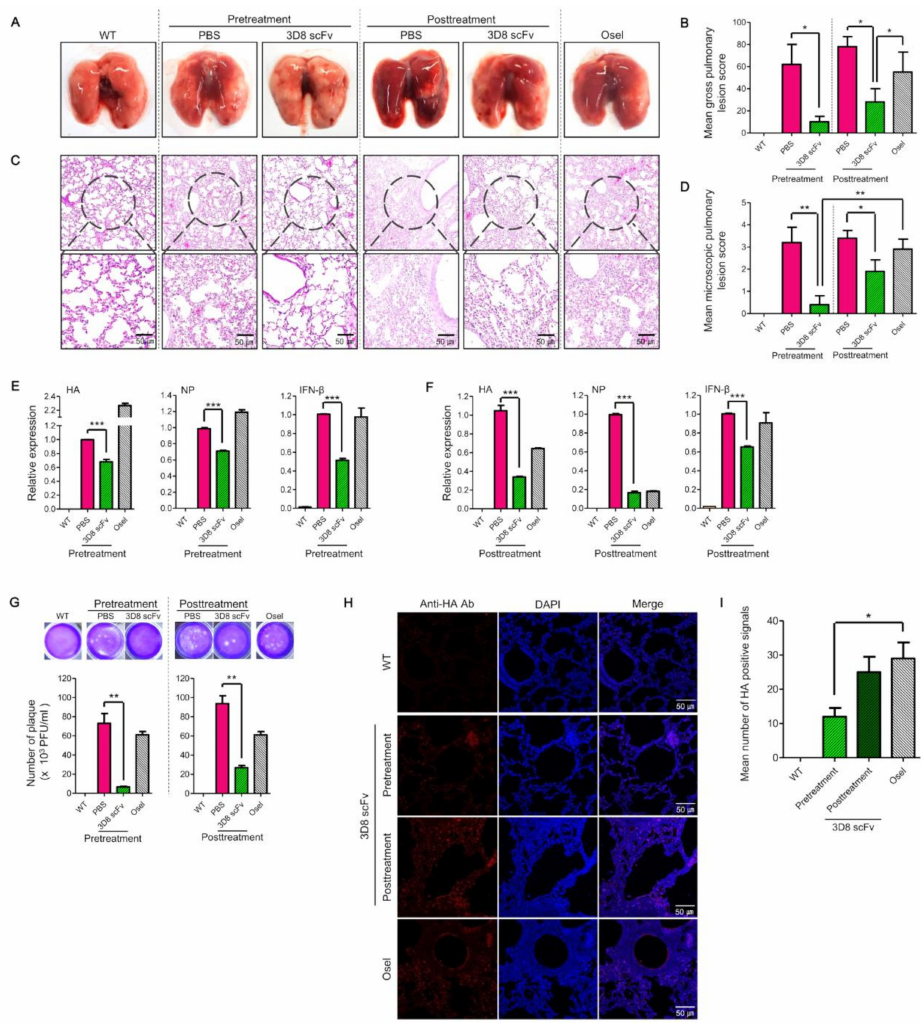
Figure 4. Histopathological analysis of the lung tissues of H1N1/H275Y-infected mice after intranasal 3D8 scFv treatment. ( A , B ) A morphological comparison and the gross pulmonary lesion scores of the mice’s lungs. The mice’s lungs were harvested at 5 dpi. ( C , D ) A histopathological comparison and the microscopic pulmonary lesion scores of the mice’s lung sections. Images of lung sections from virus-infected mice treated with 3D8 scFv. Lung tissues were stained with H&E. Scale bars represent 100 µ m. ( E , F ) Viral RNA ( HA, NP ) and expression of the inflammatory factor, IFN- β , were analyzed by qRT-PCR. The relative concentrations of RNA were calculated after normalization to GAPDH expression using the delta–delta Ct method. Data are shown as the mean ± S.E.M. of triplicate samples. ( G ) Comparison of the virus titers in the lungs by a plaque assay. ( H ) Reduction in viral protein (HA) in infected lungs detected using immunohistochemistry. Nuclei were detected using DAPI (blue), and viral HA was visualized with TRITC (red). Scale bars represent 50 µ m. ( I ) The mean number of HA-positive signals in the mice’s lungs. Error bars indicate SE. Asterisks indicate a significant difference determined by t -tests (* p < 0.05, ** p < 0.01, *** p <